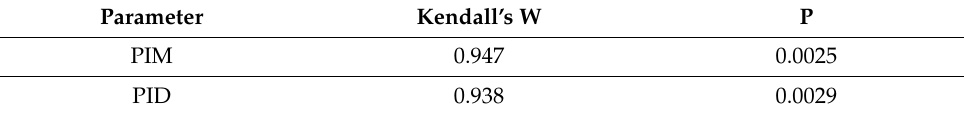
Table 5. Cont. Parameter Kendall’s